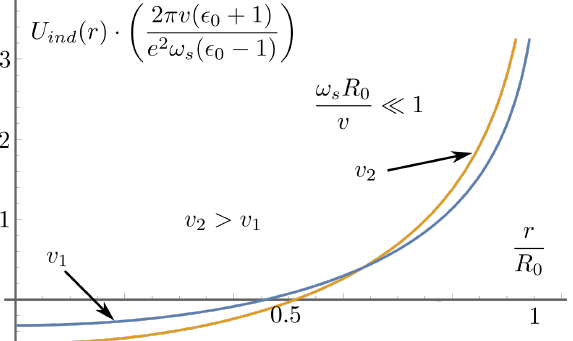
Figure 9. Dimensionless induced potential versus the distance from the cavity axis at the condition ω s R 0 / v (cid:28) 1, while a concrete plotting is for q 0 R 0 = 10 3 and ω s = 10 15 c − 1 , with the characteristic